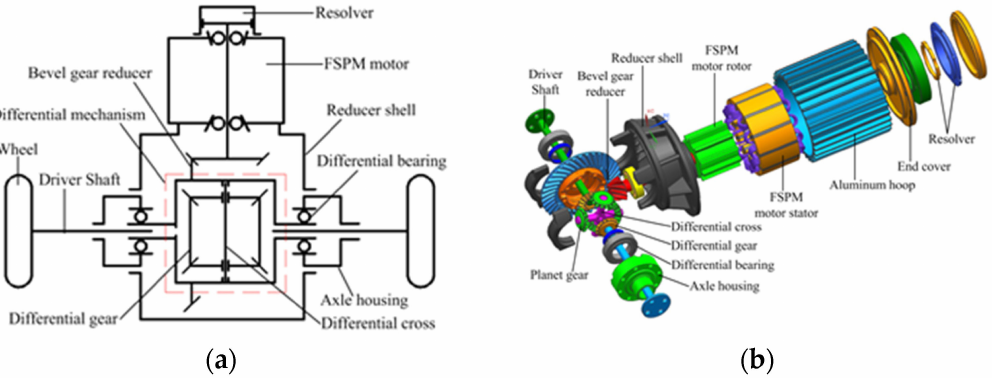
Figure 1. Drive system of a CEV with an FSPM motor. ( a ) Schematic diagram; ( b ) assembly